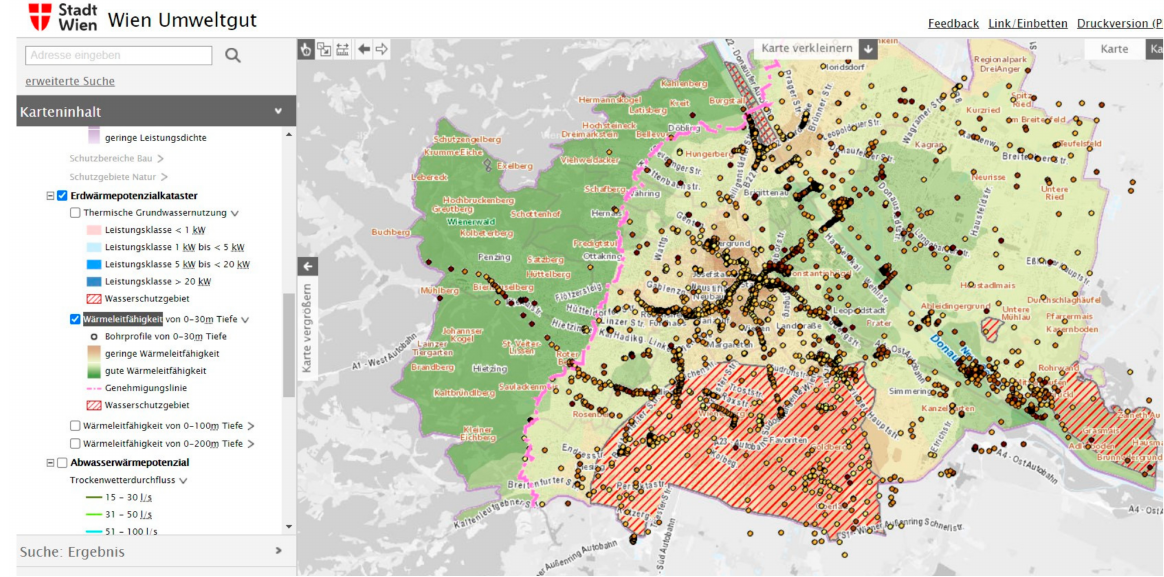
Figure 13. Environmental asset in Vienna, layer geothermal potential cadastre, areas with thermal conductivity from 0–30 m depth. Source: own study based on [127].